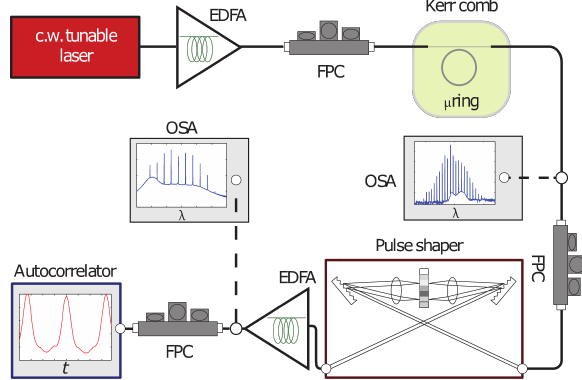
Figure 10: Experimental setup for spectral line-by-line shaping of microresonator Kerr frequency combs. EDFA: erbium-doped fiber amplifier; FPC: fiber polarization controller; µring: microring res- onator; OSA: optical spectrum analyzer. Adapted by permission from Macmillan Publishers Ltd: Nature Photonics [31], copyright